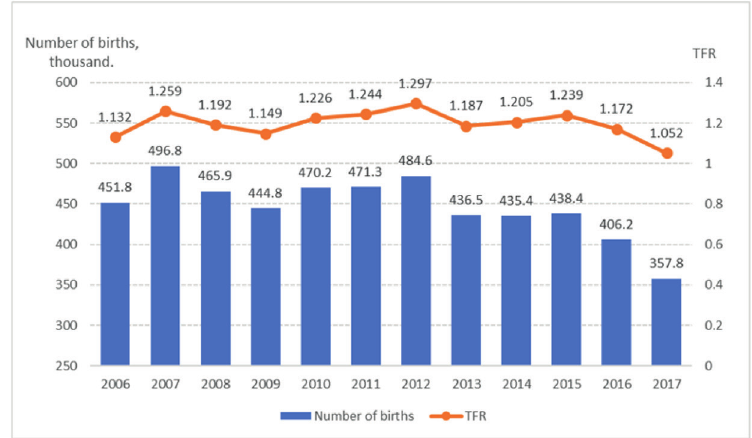
Figure 1. Number of births and total fertility rate in the Republic of Korea, 2006-2017. Source: KOSTAT, Birth Statistics 2017, № 10103.